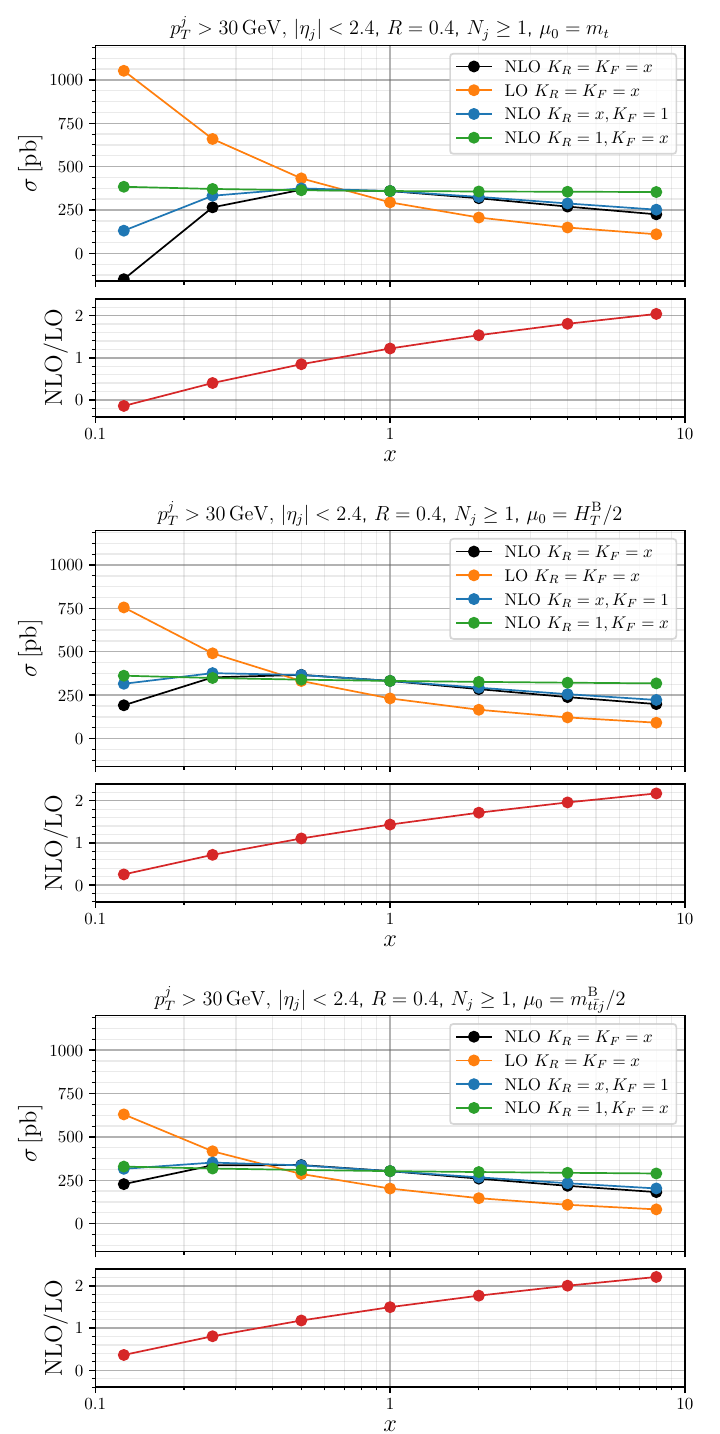
Figure 3 . Integrated cross section of the pp → t ¯ tj + X process after our default system of analysis cuts, using multiple ( K R , K F ) of the static scale definition µ 0 = m t (upper panel) and of the dynamical scale definitions µ 0 = H B / 2 (central panel) and µ 0 = m B / 2 (lower T t ¯ tj